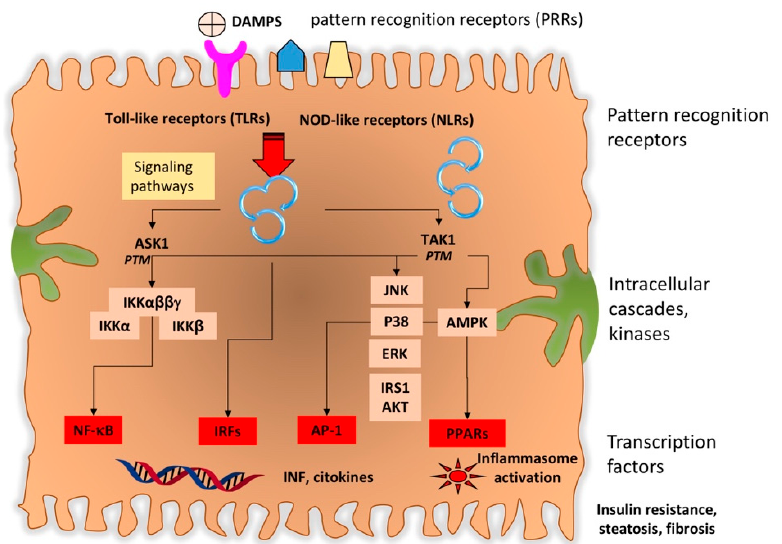
Figure 3. Detailed picture representing the ultimate consequence of circulating damage-associated molecular patterns (DAMs) on hepatocytes. DAMs represent the continuous stimulus for at least three intracellular events in the hepatocyte: (1) response of pattern recognition receptors (PRRs) such as Toll-like receptors (TLRs) and NOD-like receptors (NLRs). (2) Activation of intracellular cascades, kinases representing the downstream signaling pathways, such as the apoptosis signal-regulating kinase 1 (ASK1) and TGF-b-activated kinase 1 (TAK1). Both kinases are activated through post-transcriptional modification (PTM) and activate other key kinases (C-Jun N-terminal kinase, JNK), AMP-activated kinase, AMPK, and IkB). (3) Activation of transcription factors such as interferon regulatory factors (IRFs), nuclear factor (NF)-kB, activator protein 1 (AP-1), and peroxisome proliferator-activated receptors (PPARs). This ultimate event leads to the production of inflammatory cytokines and chemokines, with all metabolic consequences observed in NAFLD (insulin resistance, steatohepatitis, fibrogenesis, etc.). Additional endogenous targets regulating the innate immune elements in NASH include CASP8 and FADD-like apoptosis regulator (CFLAR), tumor necrosis factor (TNF) a-induced protein 3 (TNFAIP3), cylindromatosis (CYLD), transmembrane BAX inhibitor motif-containing 1 (TMBIM1), TNF receptor-associated factor 6 (TRAF6), TRAF1, TRAF3, dual-specificity phosphatase 14 (DUSP14), tripartite motif 8 (TRIM8), dickkopf-3 (DKK3), and TRAF5 (See also [41]). Ultimately, the activation of several transcription factors promotes the release of inflammatory cytokines and chemokines, and stimulates hepatic stellate cells with propensity to collagen